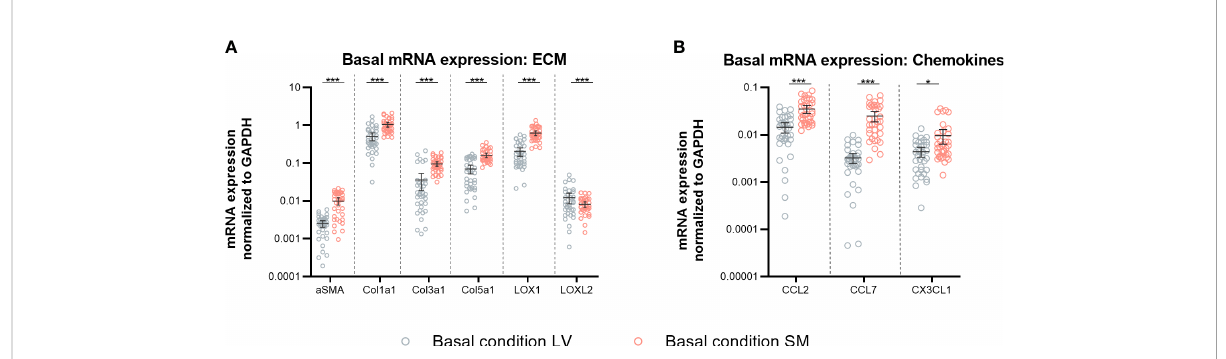
FIGURE 1 Skeletal muscle (SM)-derived fi broblasts show a higher gene expression of a -SMA, components of the extracellular matrix (ECM), and chemokines compared to left ventricle (LV)-derived fi broblasts. mRNA expression of (A) a -SMA, ECM components, and modulators (Col1a1, Col3a1, Col5a1, LOX, and LOXL2) and (B) chemokines (CCL2, CCL7, Cx3CL1) normalized to GAPDH of LV-derived (black) and SM-derived (red) fi broblasts after 24-h culture with basal medium without IL-6 (basal condition; bright hollow circle). Mean ± 95% CI; n = 36, N = 6; Mann